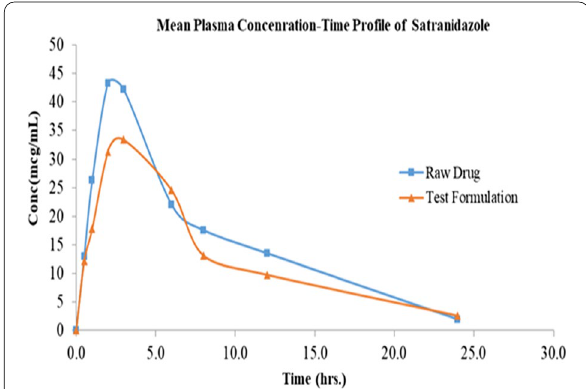
Fig. 5 Mean plasma concentration–time curves of free administered satranidazole drug and test